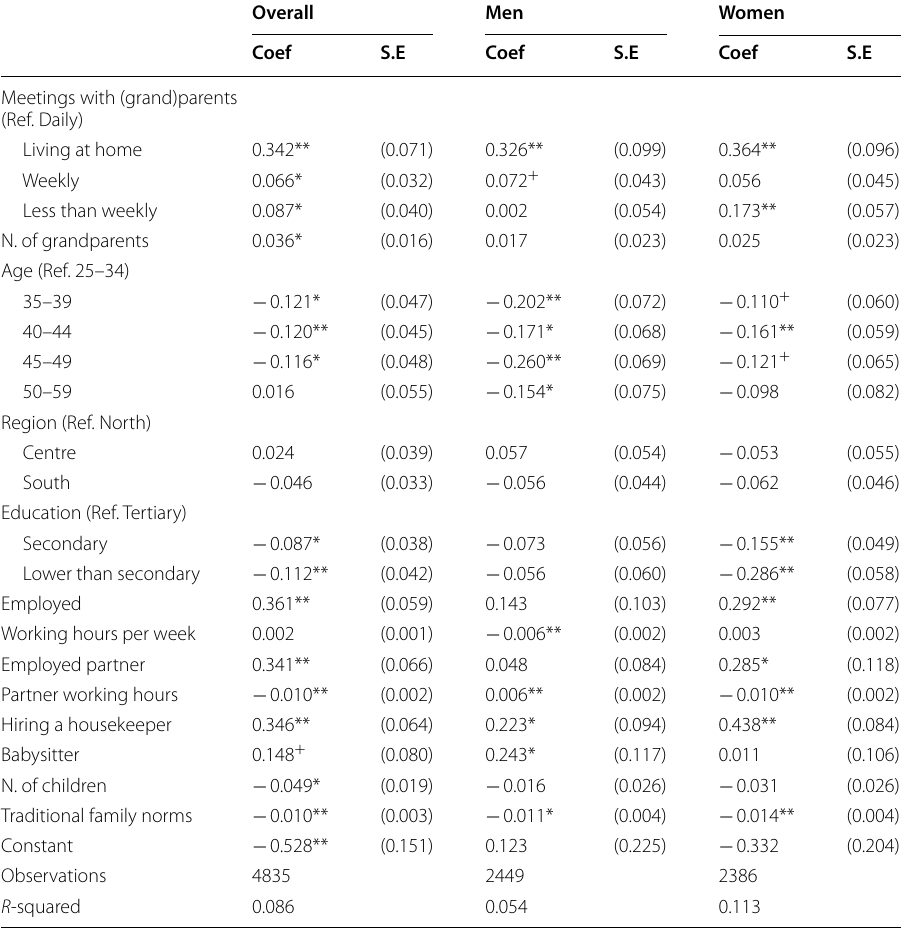
Table 7 Linear regression models on symmetry in the division of housework tasks ( Z